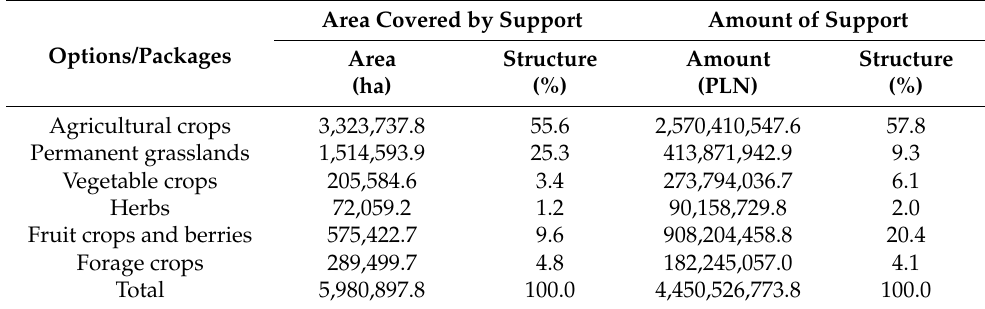
Figure 5. Payment amounts by organic farming package in the 2014–2020 RDP. Source: own compilation based on [64]. Table 7. Area under and support allocated to organic farming by option/package in